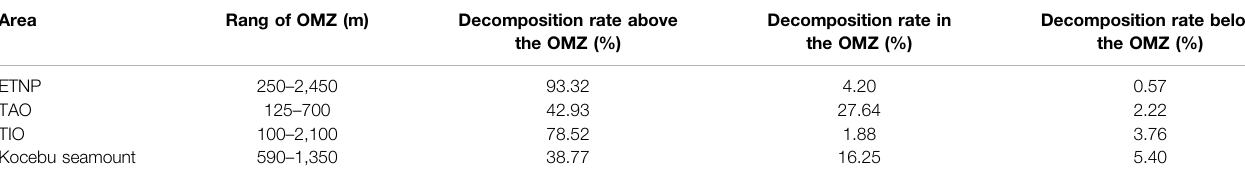
TABLE 2 | Relationship between decomposition rate of POC and OMZ in different areas.